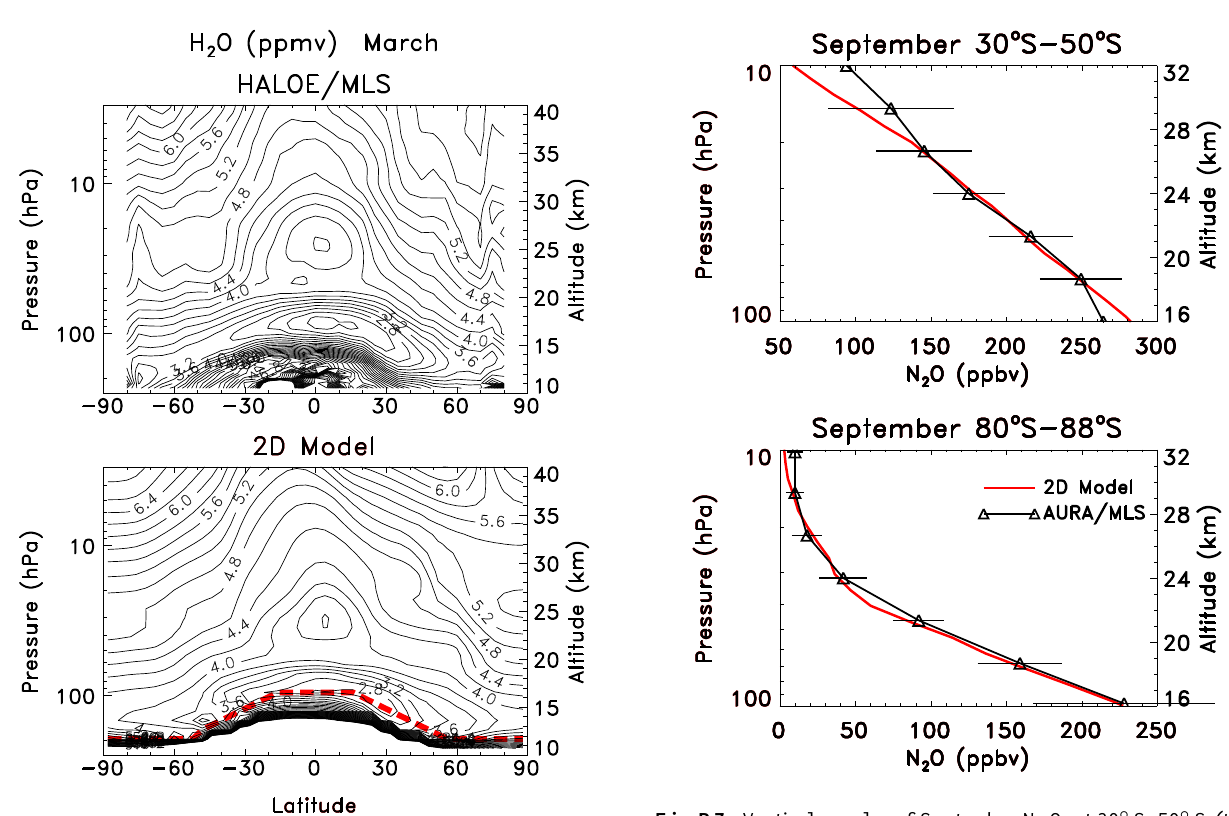
Fig. B7. Vertical profiles of September N 2 O at 30 ◦ S–50 ◦ S (top) and 80 ◦ S–88 ◦ S (bottom) from AURA/MLS observations (black Fig. B6. Latitude-height cross-sections of March H 2 O averaged triangles) and the 2-D model (red curve) averaged over 2004–2009. Figure B6. Latitude-height cross-sections of March H averaged over 1994–2004 from Figure B7. Vertical profiles of September N at 30 ◦ S–50 ◦ S (top) and 80 ◦ S–88 ◦ S (bottom) from 2 O over 1994–2004 from UARS/HALOE (top) and the 2-D model (bot- 2 O The error bars (1 σ ) denote the combined effects of measurement UARS/HALOE (top) and the 2-D model (bottom). The top panel includes data from AURA/MLS in tom). The top panel includes data from AURA/MLS in the polar re- AURA/MLS observations (black triangles) and the 2-D model (red curve) averaged over 2004–2009. uncertainty and interannual variability. The Antarctic MLS profile the polar regions (averaged over 2004–2009) where HALOE lacks data coverage. Contour interval is gions (averaged over 2004–2009) where HALOE lacks data cover- The error bars (1 σ ) denote the combined effects of measurement uncertainty and interannual variability. is adapted from SPARC CCMVal (2010). age. Contour interval is 0.2ppmv. The red dashed line separates the 0.2 ppmv. The red dashed line separates the regions where the model H is computed (above) and The Antarctic MLS profile is adapted from SPARC CCMVal (2010). 2 O regions where the model H 2 O is computed (above) and prescribed prescribed to the HALOE climatology (below). to the HALOE climatology (below). 70 71